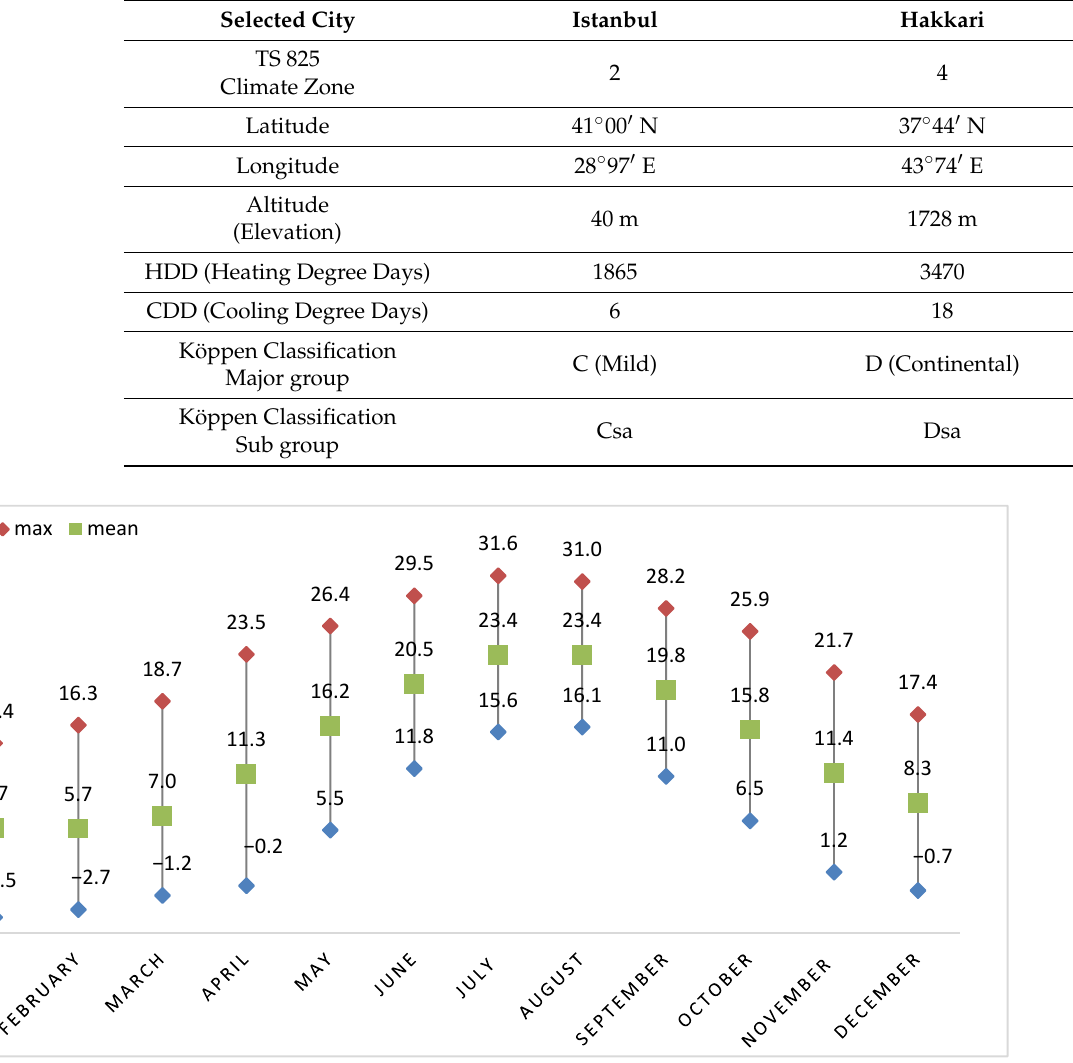
Table 4. Climatic zones, topographic features, and degree days of the selected locations.